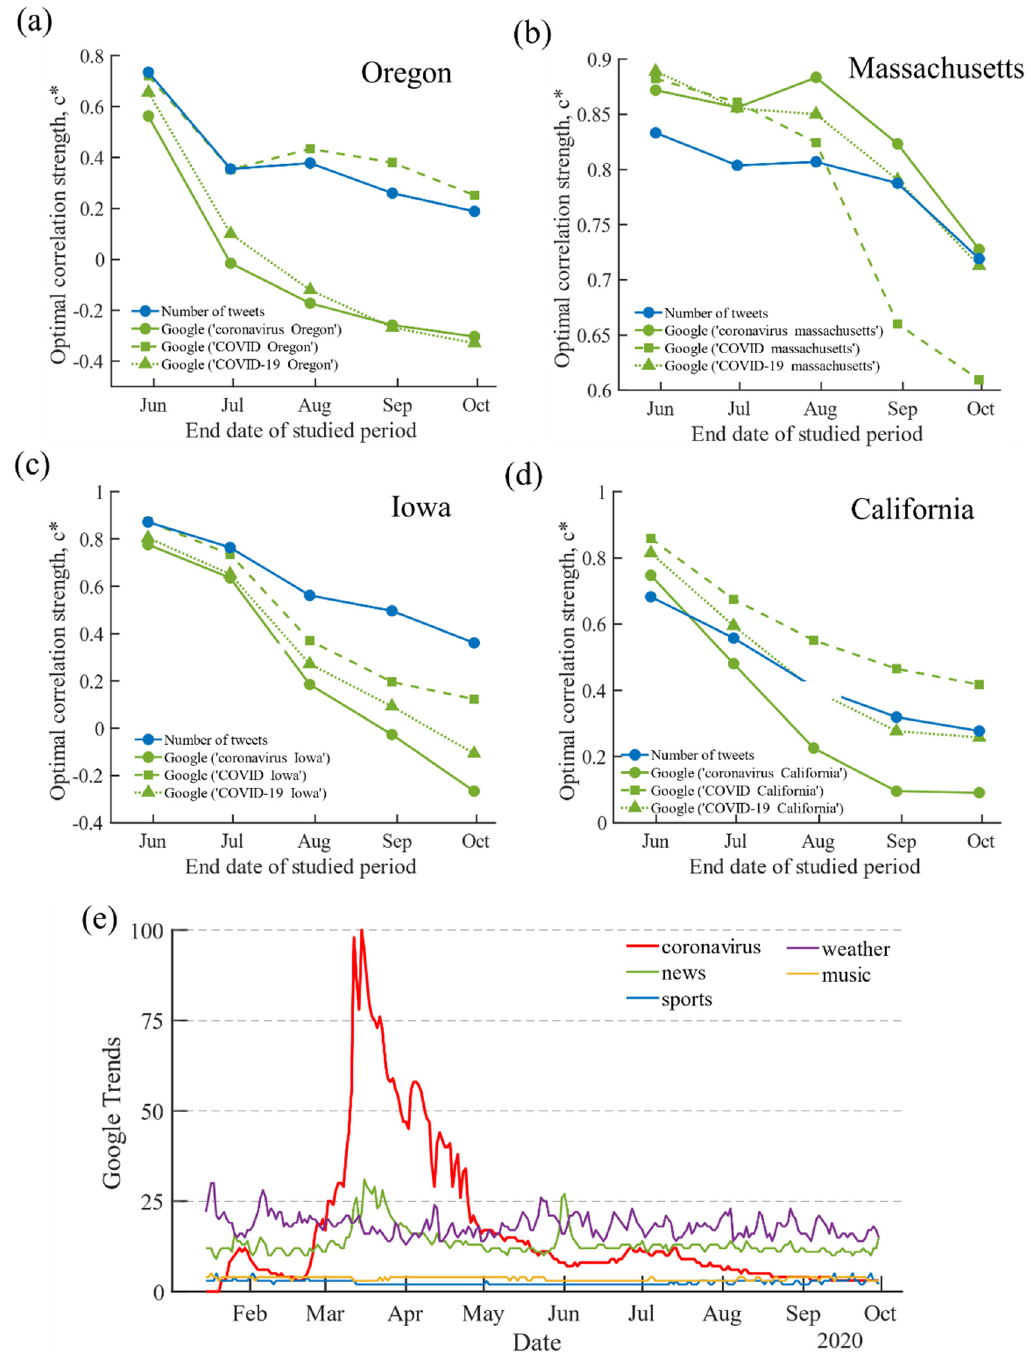
Figure 4. The change of public attention for ‘COVID-19 ′ on the Internet. ( a – d ) The highest correlation strength 𝑐 ∗ between the COVID-19 daily infection and the Internet data vs. the studied period in 4 selected states. The x-axis denotes the end date of the studied period for a given state, while the start date is chosen as the date when the first case was reported in this state. Each point of 𝑐 ∗ is obtained by applying the lagged Spearman correlation analysis (see Methods for detail). ( e ) U.S. interest about ‘coronavirus’ in Google search from 15 January 2020 to 30 September 2020, compared with other top searched topics.